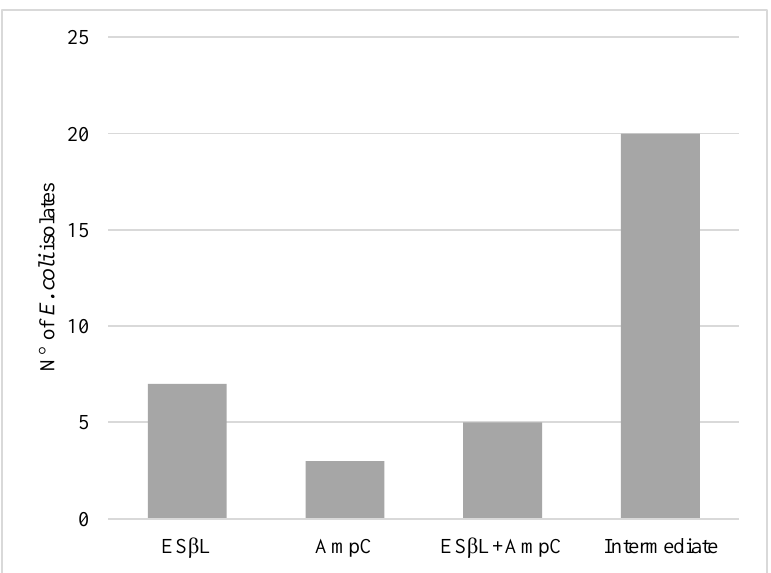
Figure 1. Number of ESβL, AmpC and ESβL + AmpC E. coli isolated from pork meat products and isolates with the intermediate profile in screening test for CTX and CAZ.